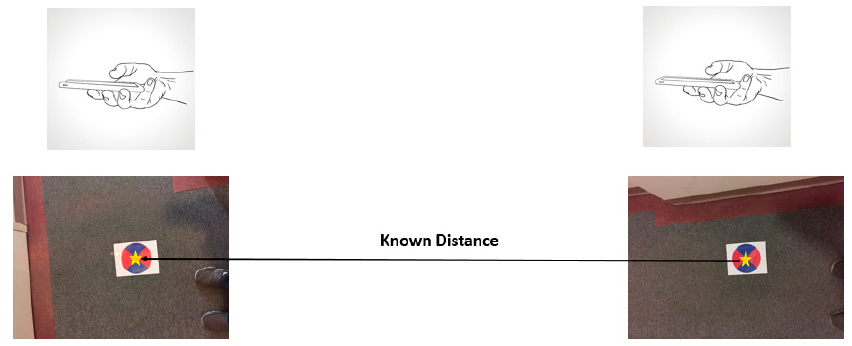
Figure 8. The Step Detection Result.